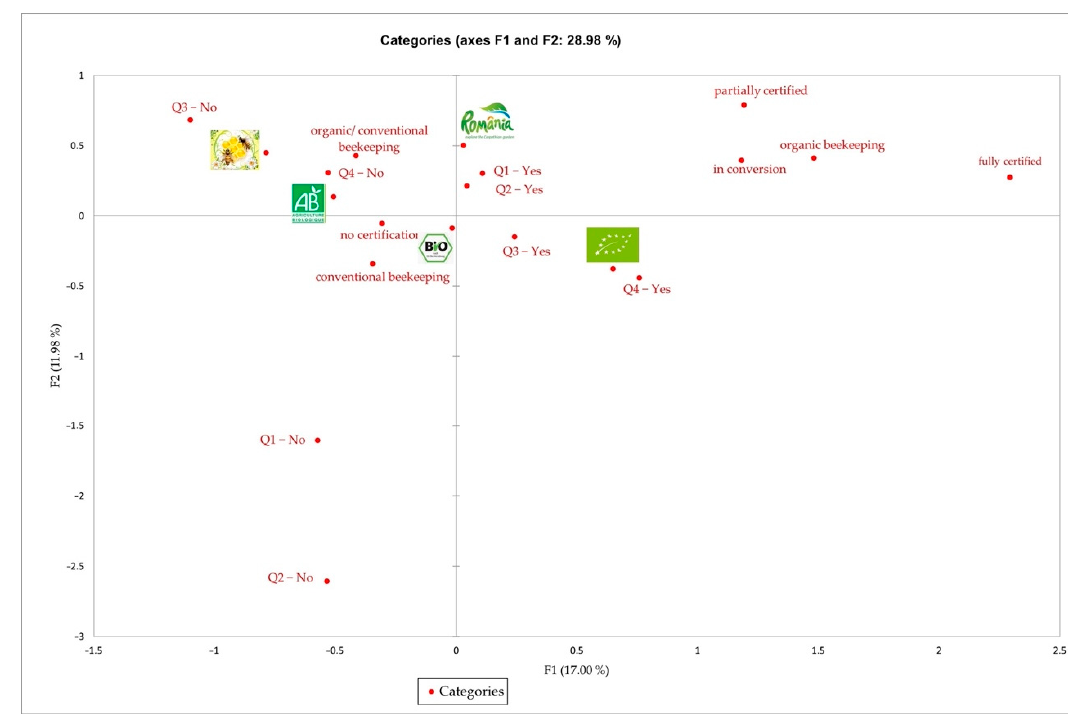
Figure 5. Multiple correspondence analysis (MCA) illustrating two-dimensional plot (F1 versus F2), created by using the following questions: type of beekeeping, logo of organic beekeeping, benefits of organic beekeeping for the environment, interest for “ecological beekeeping areas”, knowledge about organic principles, and costs involved in practicing organic beekeeping. Each question represented either binary variable with a yes/no response or variable with a multiple responses.